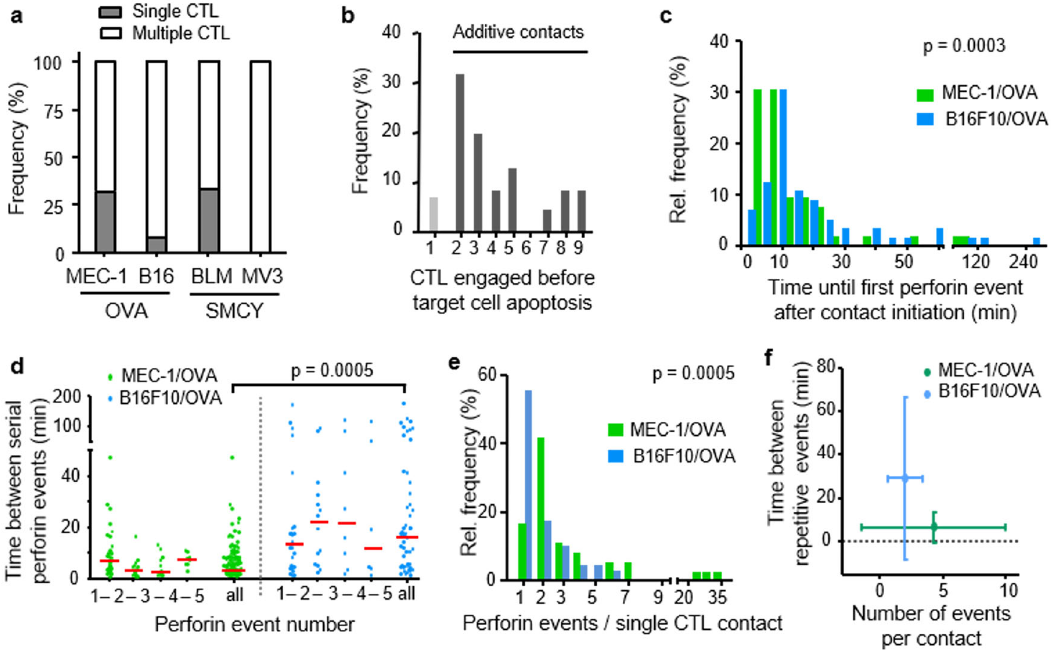
Fig. 4 Kinetics and frequency of CTL-induced sublethal events. a Percentage of apoptosis events preceded by multiple or single CTL contacts in mouse and human melanoma models. Pooled data representing ≥ 100 contacts from ≥ 3 independent experiments per cell line. b Percentage of CTL engaged before target cell death in B16F10/OVA co-culture with OT1 CTL. c Lag phase until fi rst Ca 2 + event after contact initiation in MEC-1/OVA and B16F10/ OVA target cells. Data from 55 (B16F10) and 52 (MEC-1) Ca 2 + events. p -Value, two-tailed Mann – Whitney test. d Intervals between sequential Ca 2 + events in the target cell induced by the same CTL in one single contact. Medians were 4 min (MEC-1/OVA) and 18 min (B16F10/OVA). Red line, median. Data show 53 (B16F10) and 119 (MEC-1) Ca 2 + events. p -Value, two-tailed Mann – Whitney test. e Number of Ca 2 + events associated with the same CTL. Data show 55 (B16F10) and 36 (MEC-1) CTL. Data from b to d pooled from three (B16F10) and two (MEC-1) independent experiments. p -Values, two- tailed Mann – Whitney test. f Number of Ca 2 + events per CTL contact plotted against frequency of sequential Ca 2 + events in MEC-1/OVA cells compared to the B16F10/OVA cells. Data from 53 (B16F10) and 119 (MEC-1) Ca 2 + events pooled from 3 (B16F10/OVA) and 2 (MEC-1/OVA) independent experiments. Source data are provided as a Source Data fi